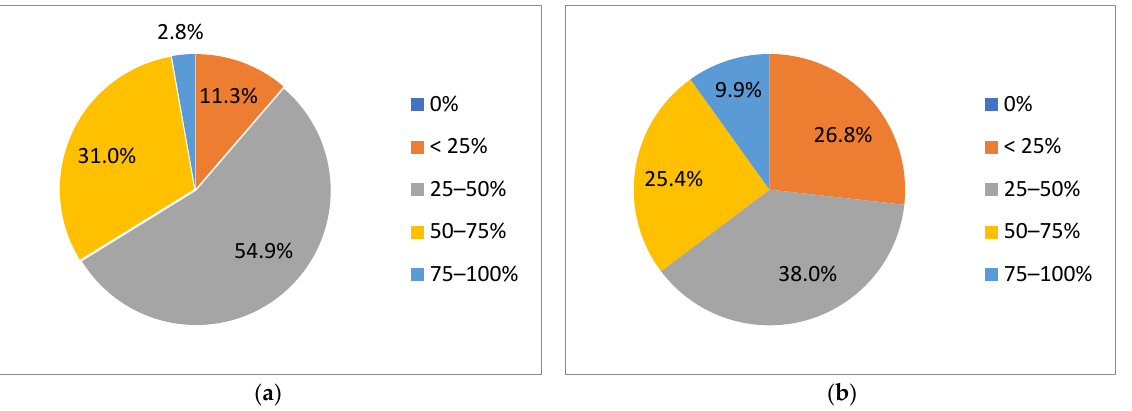
Figure 3. Estimation of time savings ( a ) and correction times ( b ) regarding organs at risk segmenta ‐ tion.